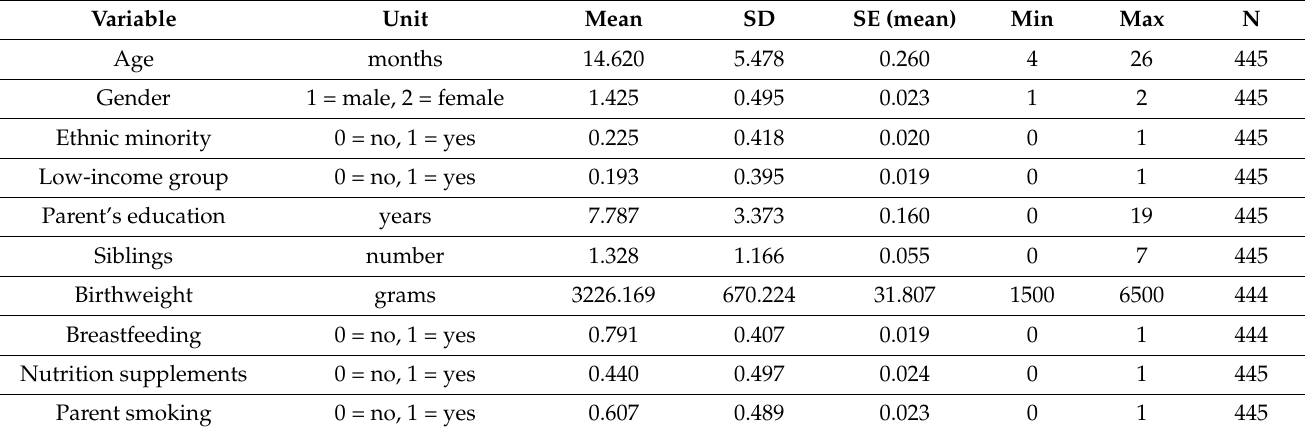
Table 1. Descriptive statistics of child and family